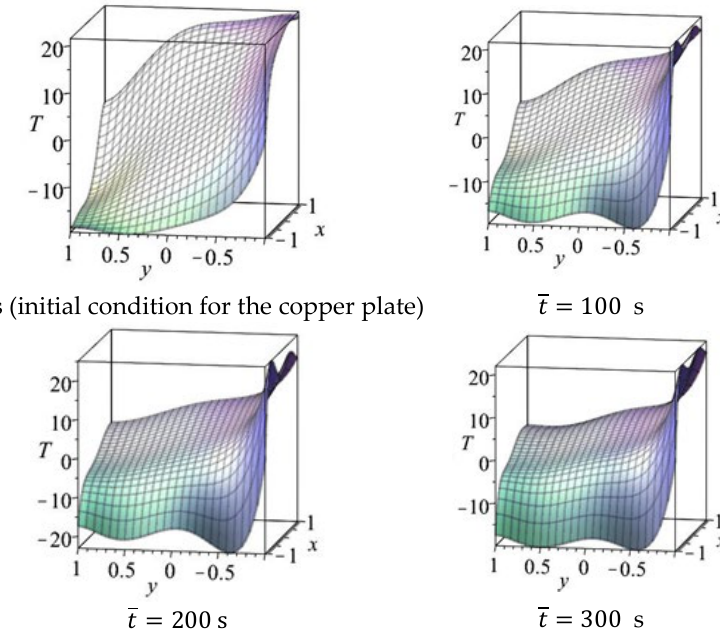
and for °C, 0.5 𝑧𝑧 = 0 𝑇𝑇 𝜌𝜌 = − 19 𝑣𝑣 𝑎𝑎 =